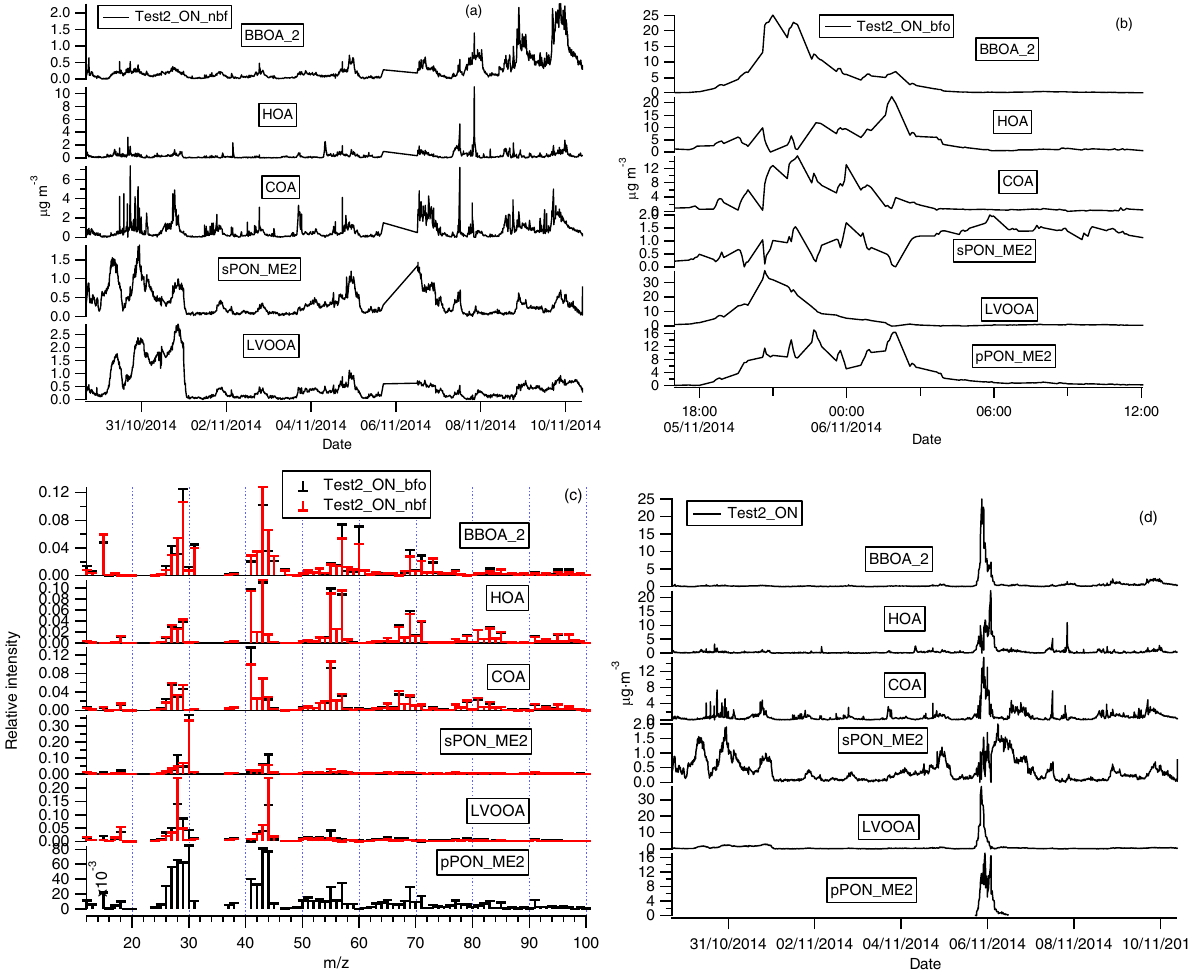
Figure 5. OA sources mass spectra and time series for Test2_ON for bonfire only (bfo) and not bonfire events (nbf). Figure 6d shows time series of both